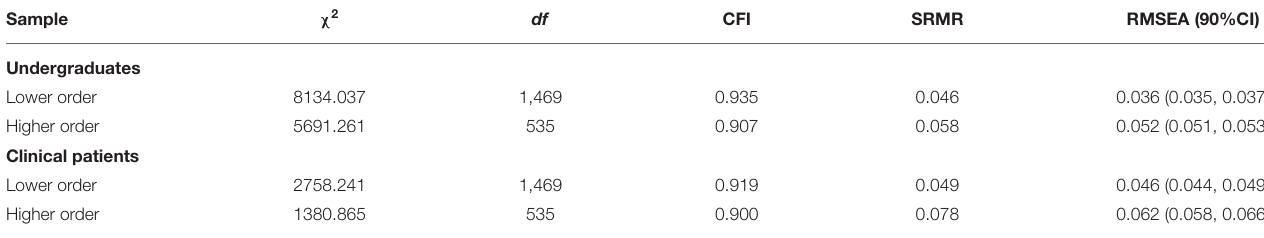
TABLE 3 | Confirmatory factor analysis results.